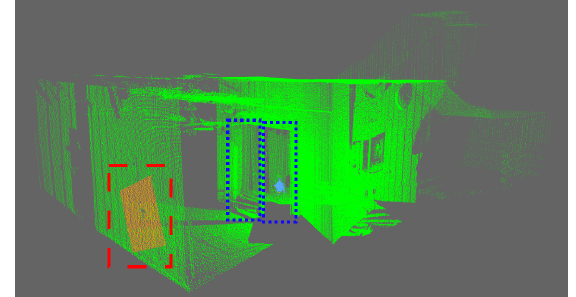
Figure 7: Cleaned scan of stairway with a glass door. Valid points are green, points on the glass facade plane are turquoise, and points behind the glass facade plane are orange. Points located on the glass surface are coloured turquoise and marked by a blue dotted line rectangle. Points located behind the surface are coloured orange and marked by a red broken line rectangle. The size of the glass surface was bigger than the mirror in Experiment 1. It is obvious that the identified surface size is smaller. Besides, the shape of the recognised area is round, cf., Figure 8. This results from the different behaviour of transparent and reflective surfaces. The center point of the detected area in Figure 8 was hit perpendicular by the laser beam while the outer points were hit from the maximal recognisable angle of glass.